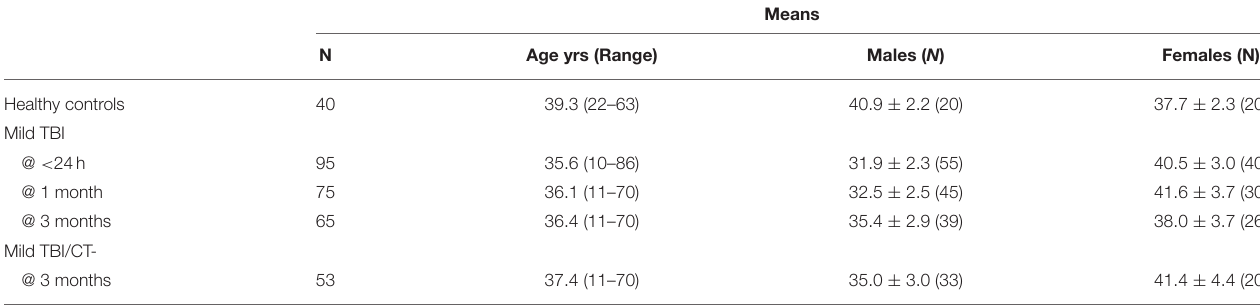
TABLE 1 | Study demographics.